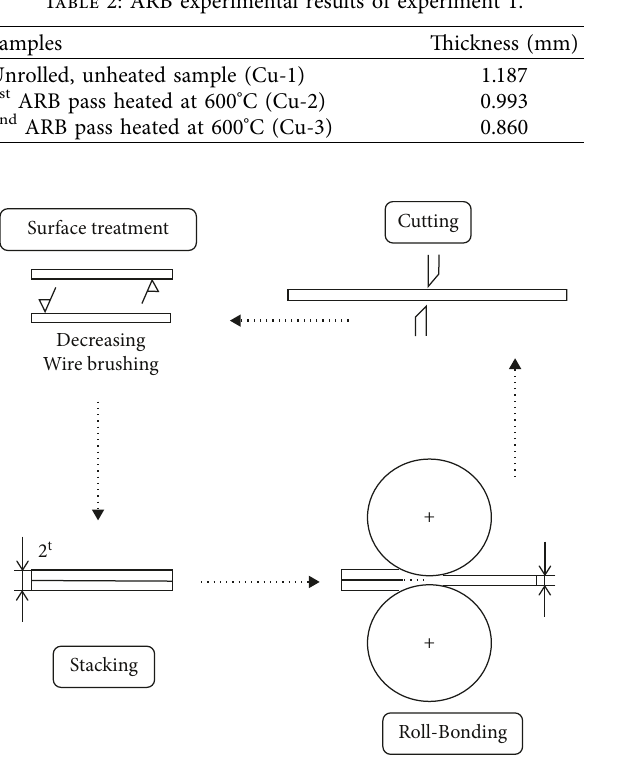
Figure 1: Schematic illustration of the ARB process